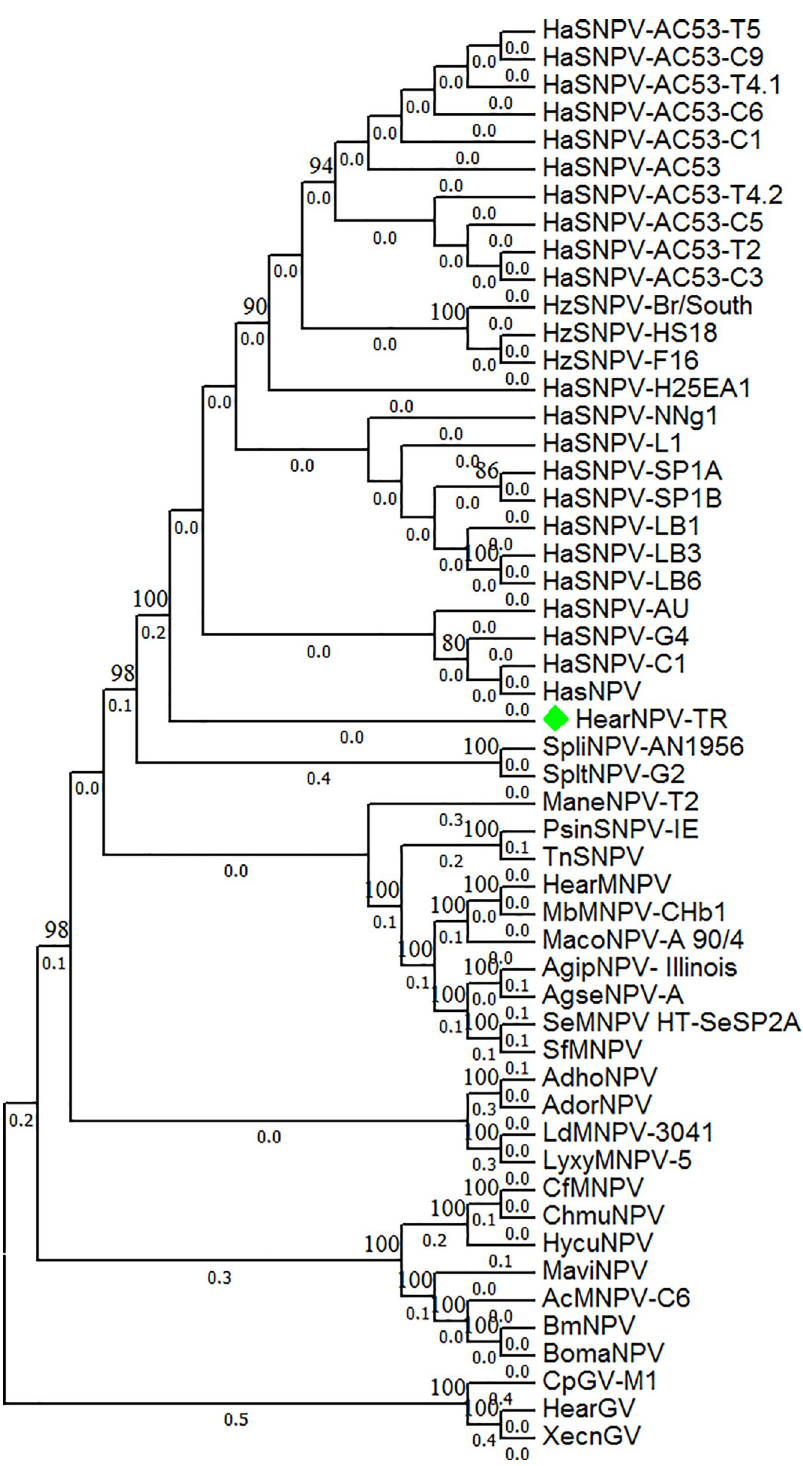
Fig 3. Phylogenetic analysis of HearNPV-TR based on concatenated sequences encoded by all 38 baculovirus core genes.